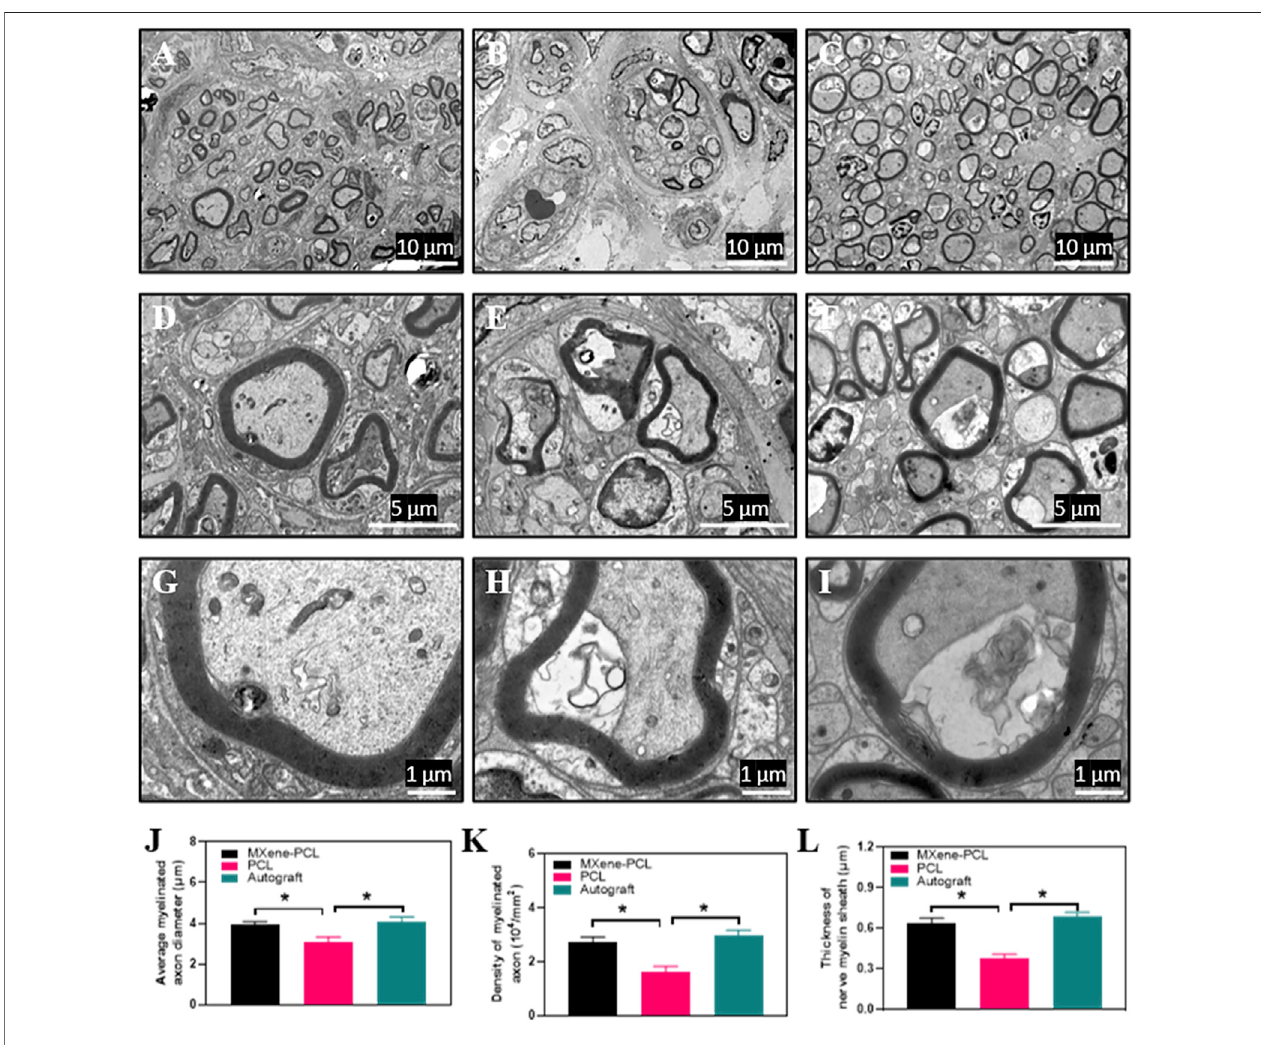
FIGURE 7 | TEM images for cross-sections of regenerated nerves from the MXene-PCL conduit (A,D,G) , the PCL conduit (B,E,H) , and the autograft (C,F,I) , at 12 weeks postoperatively. The statistical analysis of average myelinated axon diameter (J) , the density of myelinated axon (K) and thickness of nerve myelin sheath (L) . All specimens were observed by TEM. Experiments were repeated three times. * p < .05. The scale bars are 10 μ m (A – C) , 5 μ m (D – F) and 1 μ m (G – I) ,